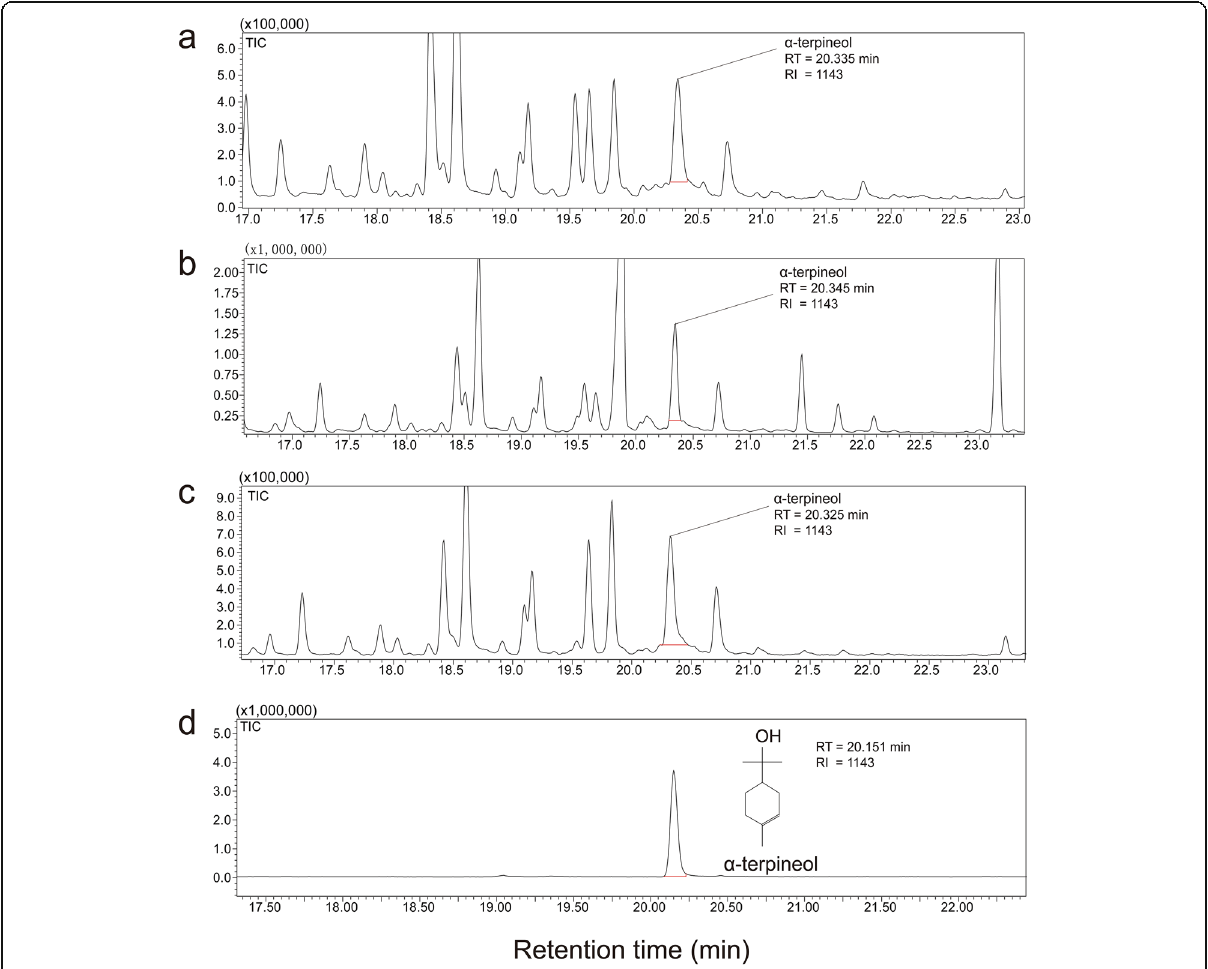
Fig. 1 Total ion current (TIC) chromatogram of VOCs emitted by pine needle powder of Pinus yunnanensis . a TIC chromatogram of the sample collected from Deqing County (28°2 ′ 5 ″ N, 99°29 ′ 22 ″ E, 2860 m). b TIC chromatogram of the sample collected from Lijiang City (26°57 ′ 16 ″ N, 100°3 ′ 34 ″ E, 1840 m). c TIC chromatogram of the sample collected from Chuxiong City (24°42 ′ 37 ″ N, 101°21 ′ 17 ″ E, 1640 m). d TIC chromatogram from the synthetic standard sample of α -terpineol. RT and RI indicate retention time and retention index,